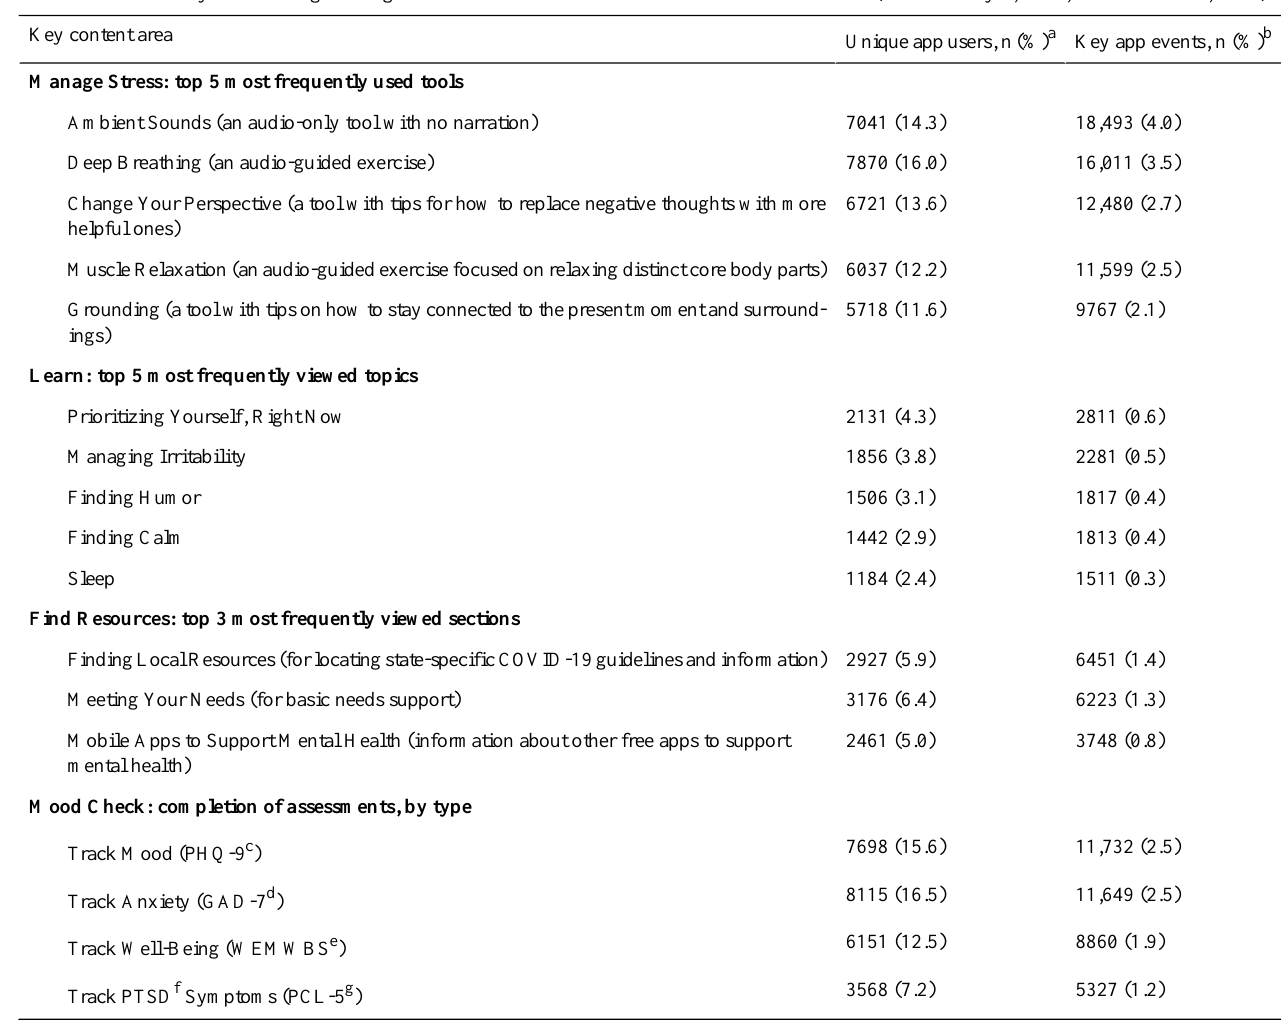
Table 2. Detailed key content usage among all COVID Coach users within the observation window (between May 1, 2020, and October 31,